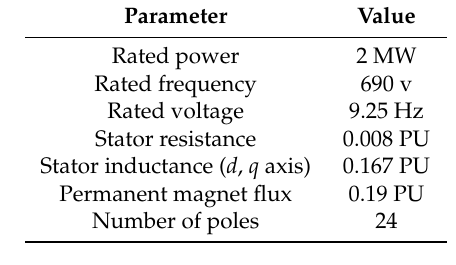
Table 4. PMSG wind turbine data.